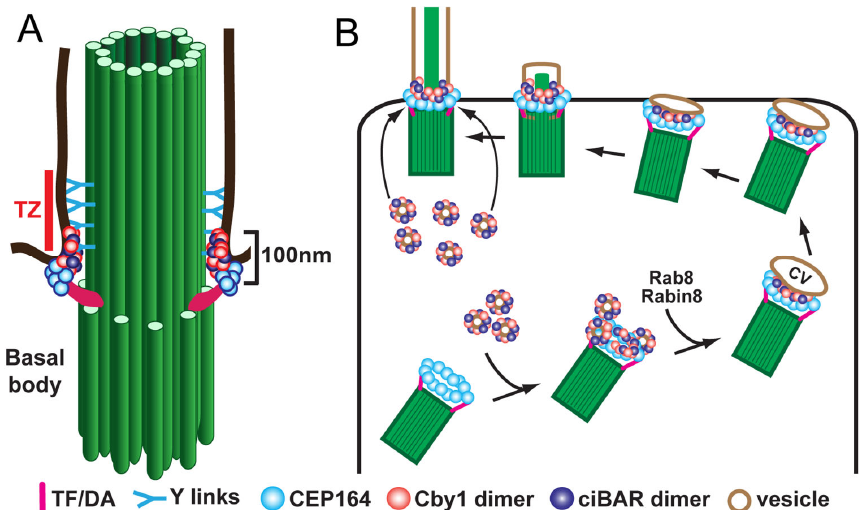
Figure 2. Model for localization ( A ) and function ( B ) of Cby1 and its associated proteins in airway MCCs. Cby1 clusters at the ciliary base as a ring with a diameter of 300 nm and a height of 100 nm [13]. Cby1 and its interactors are essential for the efficient docking of basal bodies to the apical membrane. TZ, transition zone; TF, transition fiber; DA, distal appendage; CV, ciliary vesicle.